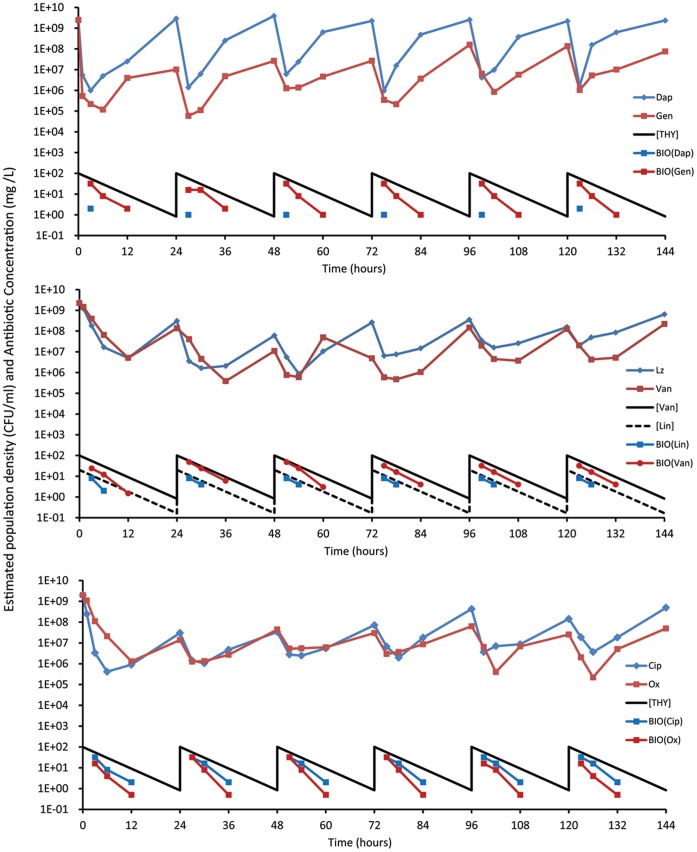
Changes in the viable cell densities (CFU/ml) of S. aureus and concentrations of antibiotics (X MIC) in continuous cultures treated every 24 hours with antibiotics of six classes.The dilution rate of these continuous cultures was w = 0.2 h−1. Save for linezolid, which was administered at 20× MIC, the daily treatment concentrations of these drugs were 100× their respective MICs. The changes in the concentrations of the antibiotics in the solid line are those calculated from equation (1). The antibiotic concentrations estimated from the bioassay are noted in the lines with points. Top panel daptomycin (1.0±0.32×107), gentamicin (1.9±0.67×106); Middle panel linezolid (2.2±0.83×107) and vancomycin (8.4±4.1×106); Bottom panel, ciprofloxacin (6.3±1.6×106) and oxacillin (4.5±1.3×106). The numbers in parentheses are the daily estimates of the harmonic mean densities of viable cell (CFU data) of the continuous cultures treated with the noted antibiotic and the standard errors of those estimates over the 6 days of “treatment”. In Table S1 we present bioassay estimates of the concentrations of these antibiotics.